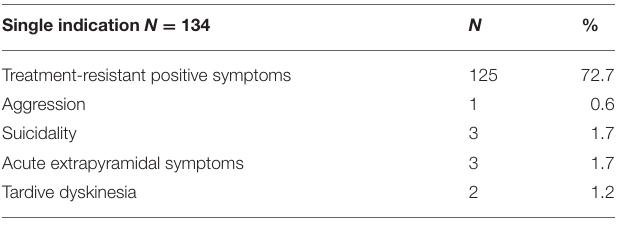
FIGURE 1 | Per team: proportions of current users of clozapine, of previous users, of those with an indication for this drug, and of those as yet insufficiently treated to have a diagnosis of treatment-resistance. The first 20 bars are the FACT-teams, and the last three bars are the early intervention teams. TABLE 3 | Type of indication for clozapine among 172 patients with Non-Affective Psychotic Disorder, with an unfulfilled indication, from 20 Flexible Assertive Community Treatment (FACT)-teams and 3 early intervention teams in the Netherlands,